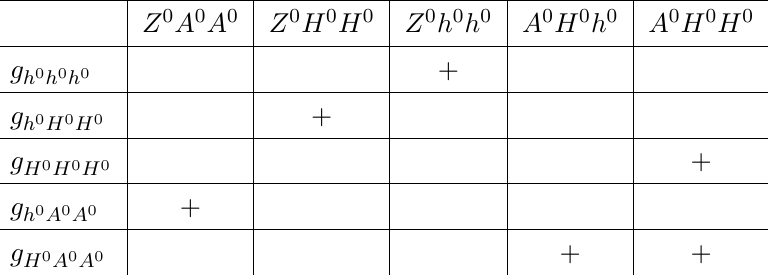
= m are set. H 0 A 0